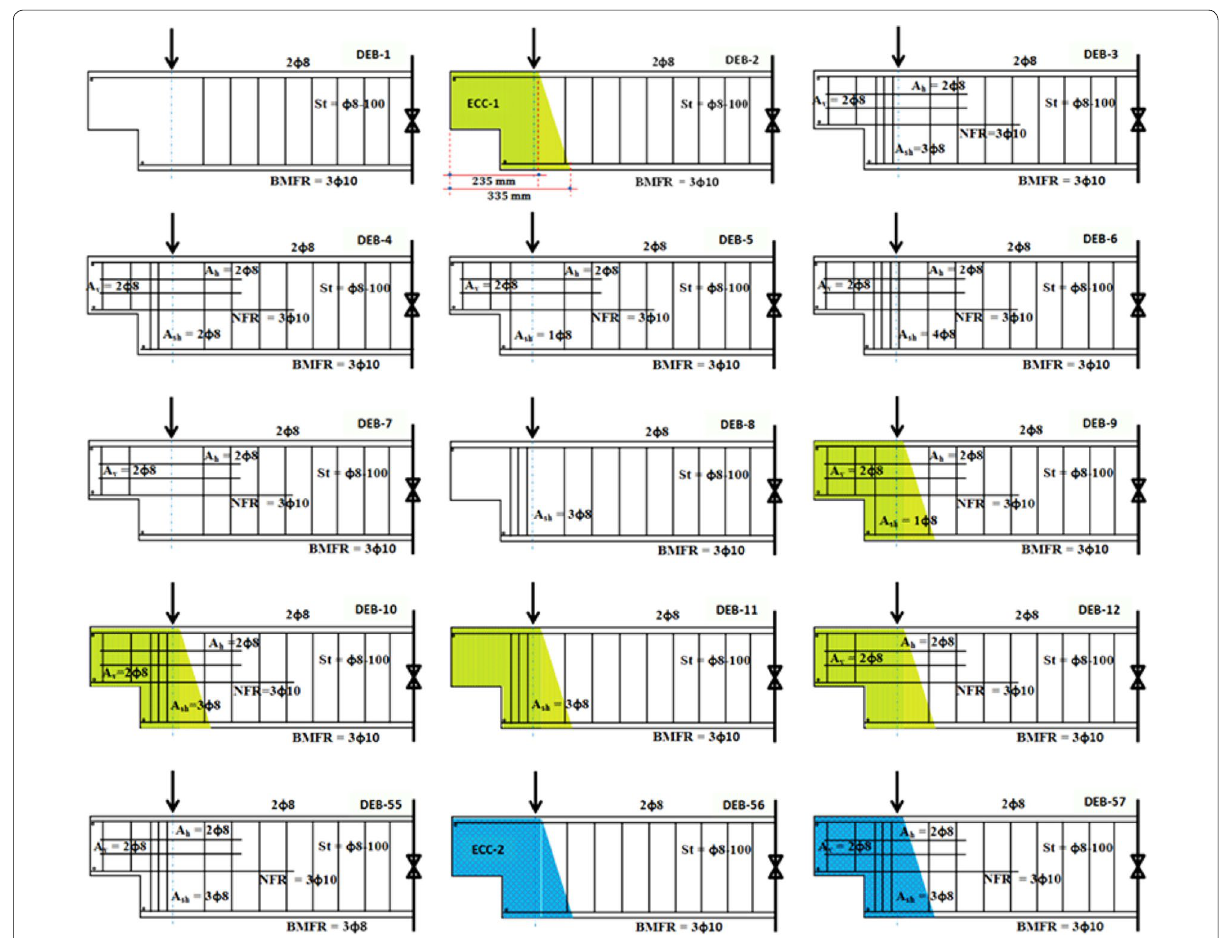
Fig. 2 The steel reinforcement configuration of DEBs in the first